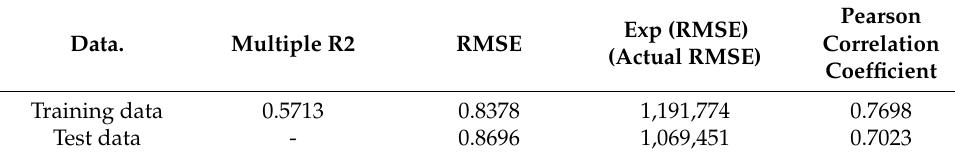
Table A2. K-fold validation for multiple regression analysis (K = 10, n = 500).